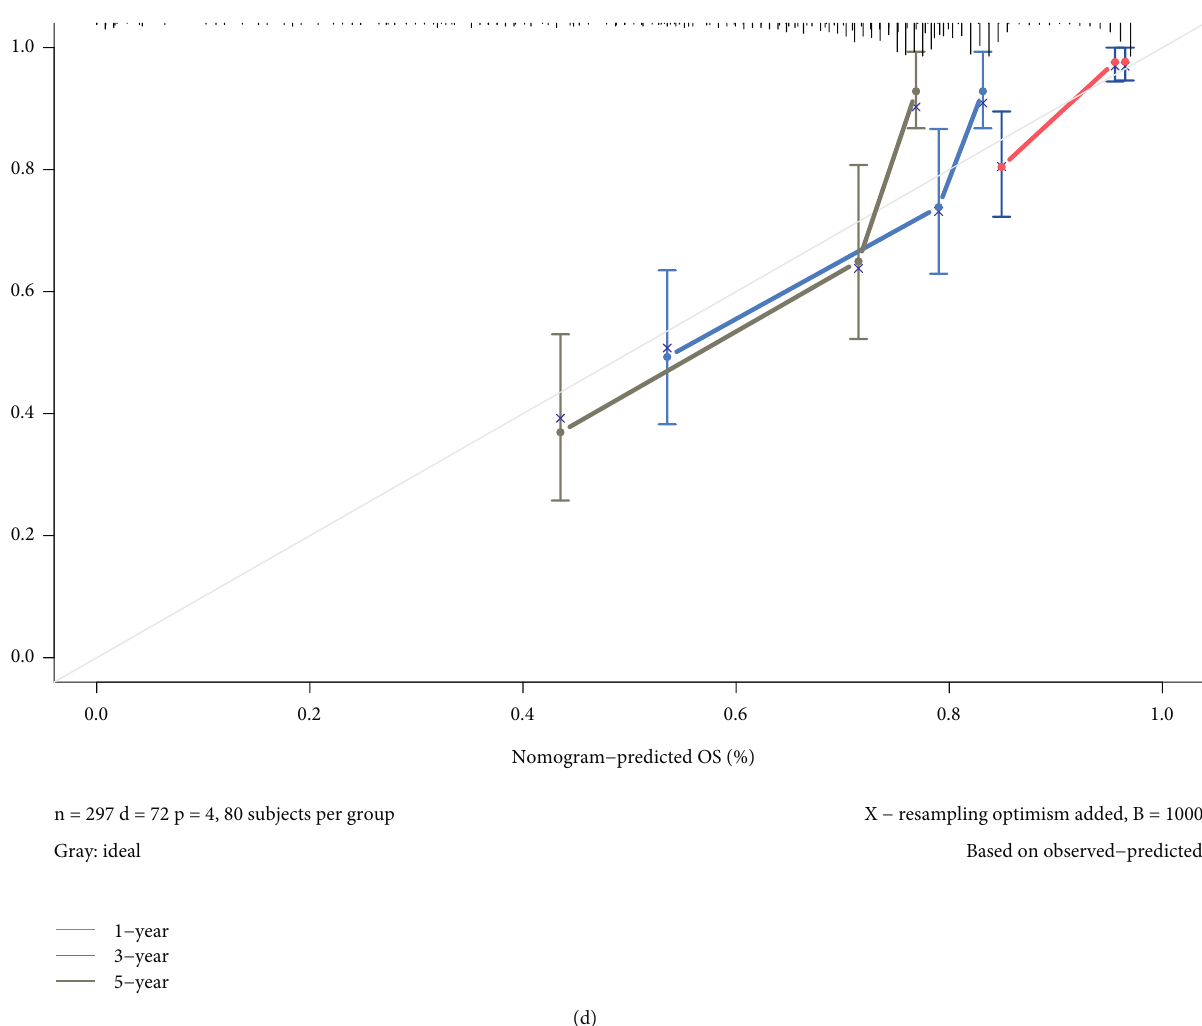
Figure 9: Nomogram to predict the probability of patients with cervical cancer. (a) The univariate Cox regression analysis of the risk score for the TCGA dataset with clinicopathologic factors. (b) The univariate Cox regression analysis of the risk score for the TCGA dataset with clinicopathologic factors. (c) A nomogram constructed by the integration of the risk score with Figo_stage to predict 1-, 3-, or 5-year OS. (d) The calibration plots for predicting patient 1-, 3-, or 5-year